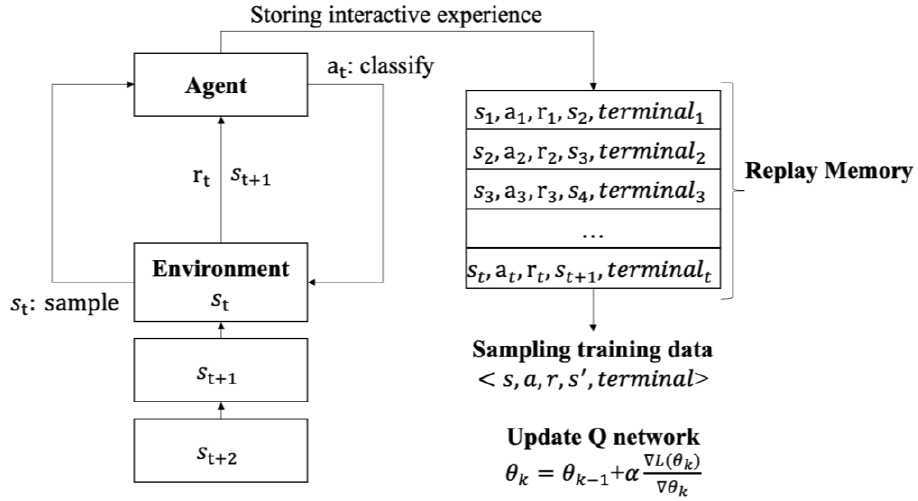
Figure 11. ICMDP process.